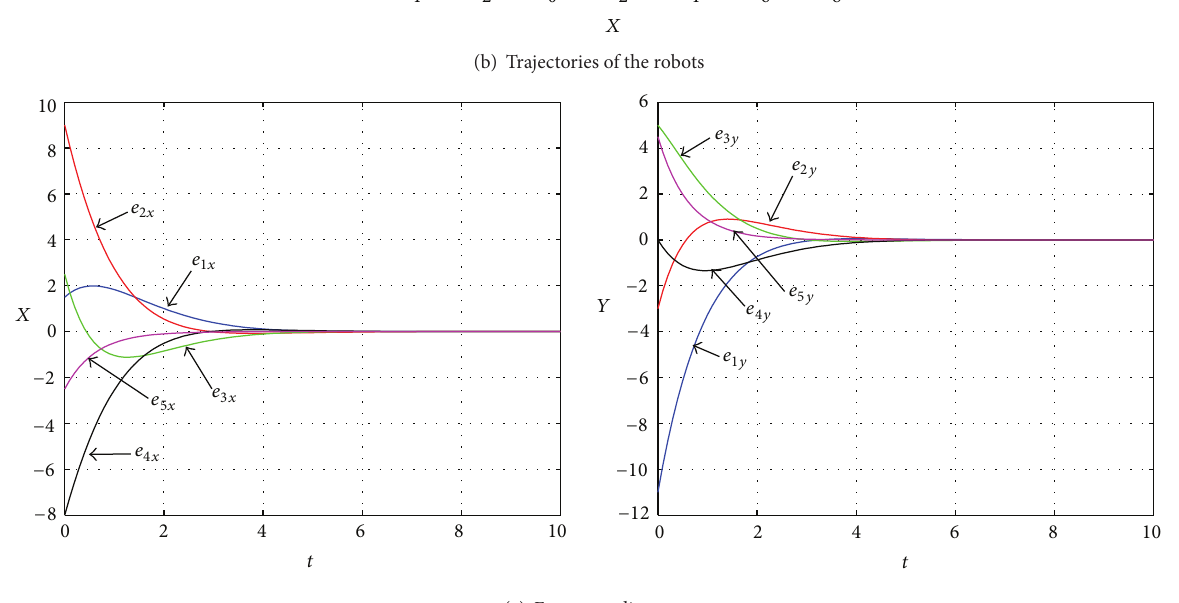
Figure 2: Formation control of a mixed